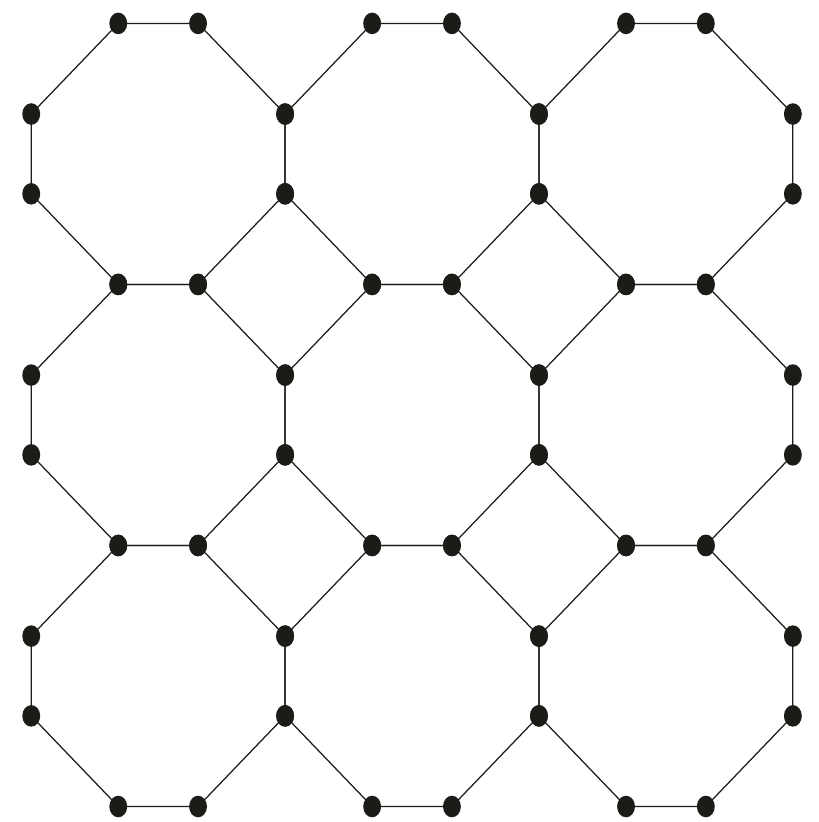
Figure 1: Graph of octa-graphyne nanosheet O Ǥ m n Nano 1 ×